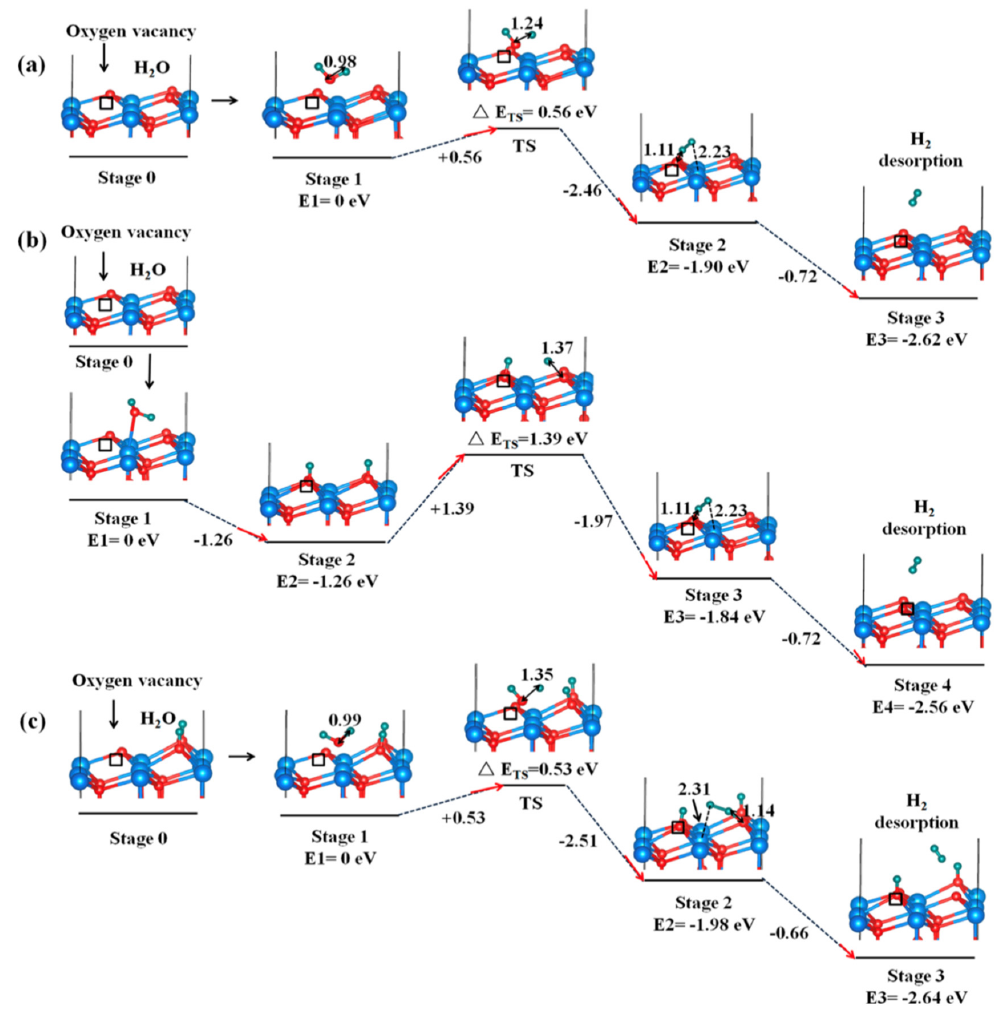
Figure 10. H 2 O dissociation and H 2 production on reduced UO 2 (111) surface through three different reaction pathways ( a – c ) [54]. Table 7. The reaction energy of H 2 O splitting and H 2 formation (H 2 O → O* + H 2 ) on perfect ThO 2 , UO 2 , and PuO 2 (111) surfaces and corresponding surfaces with oxygen vacancies. A negative / positive value represents the reaction is exothermic / endothermic,